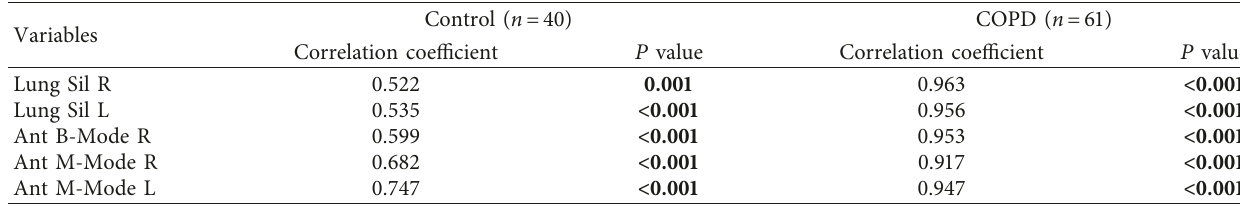
Figure 3: Box and whisker plot. Lung Sil R (mm), Lung Sil L (mm), Ant M-mode R (mm), Ant M-Mode L (mm), and Ant B-Mode R (mm) values in patients with COPD in accordance with GOLD classification in 95% confidence interval. Table 3: Correlation between FEV1 and ultrasonographic